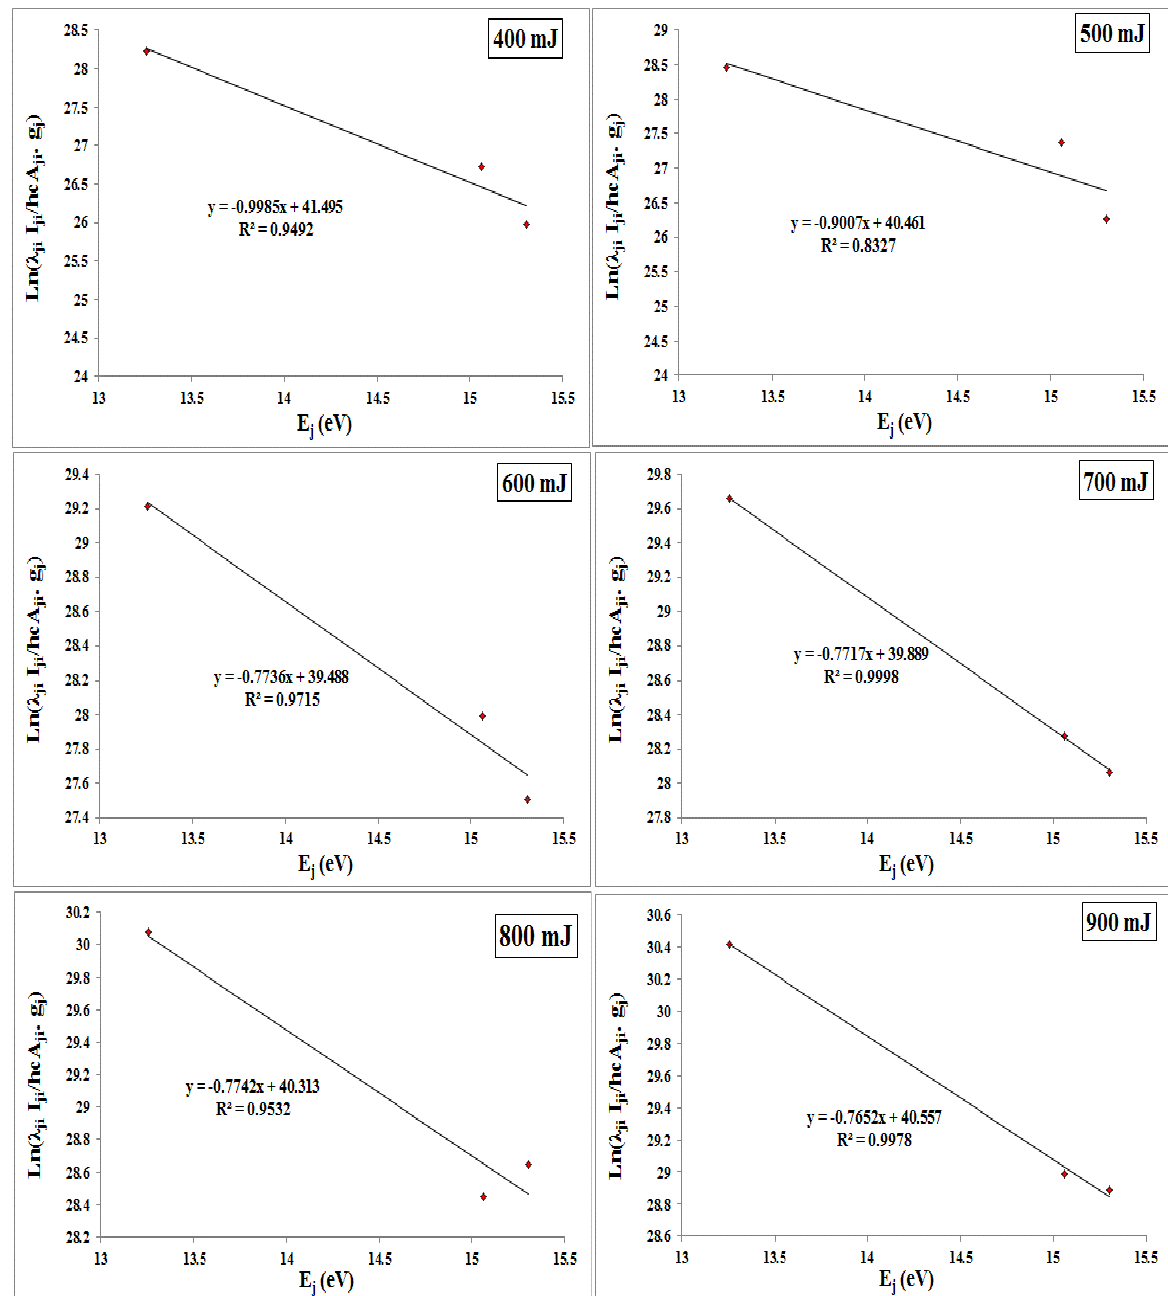
Fig.5: Boltzmann plot method for aluminum target using 1064 nm laser, with different laser